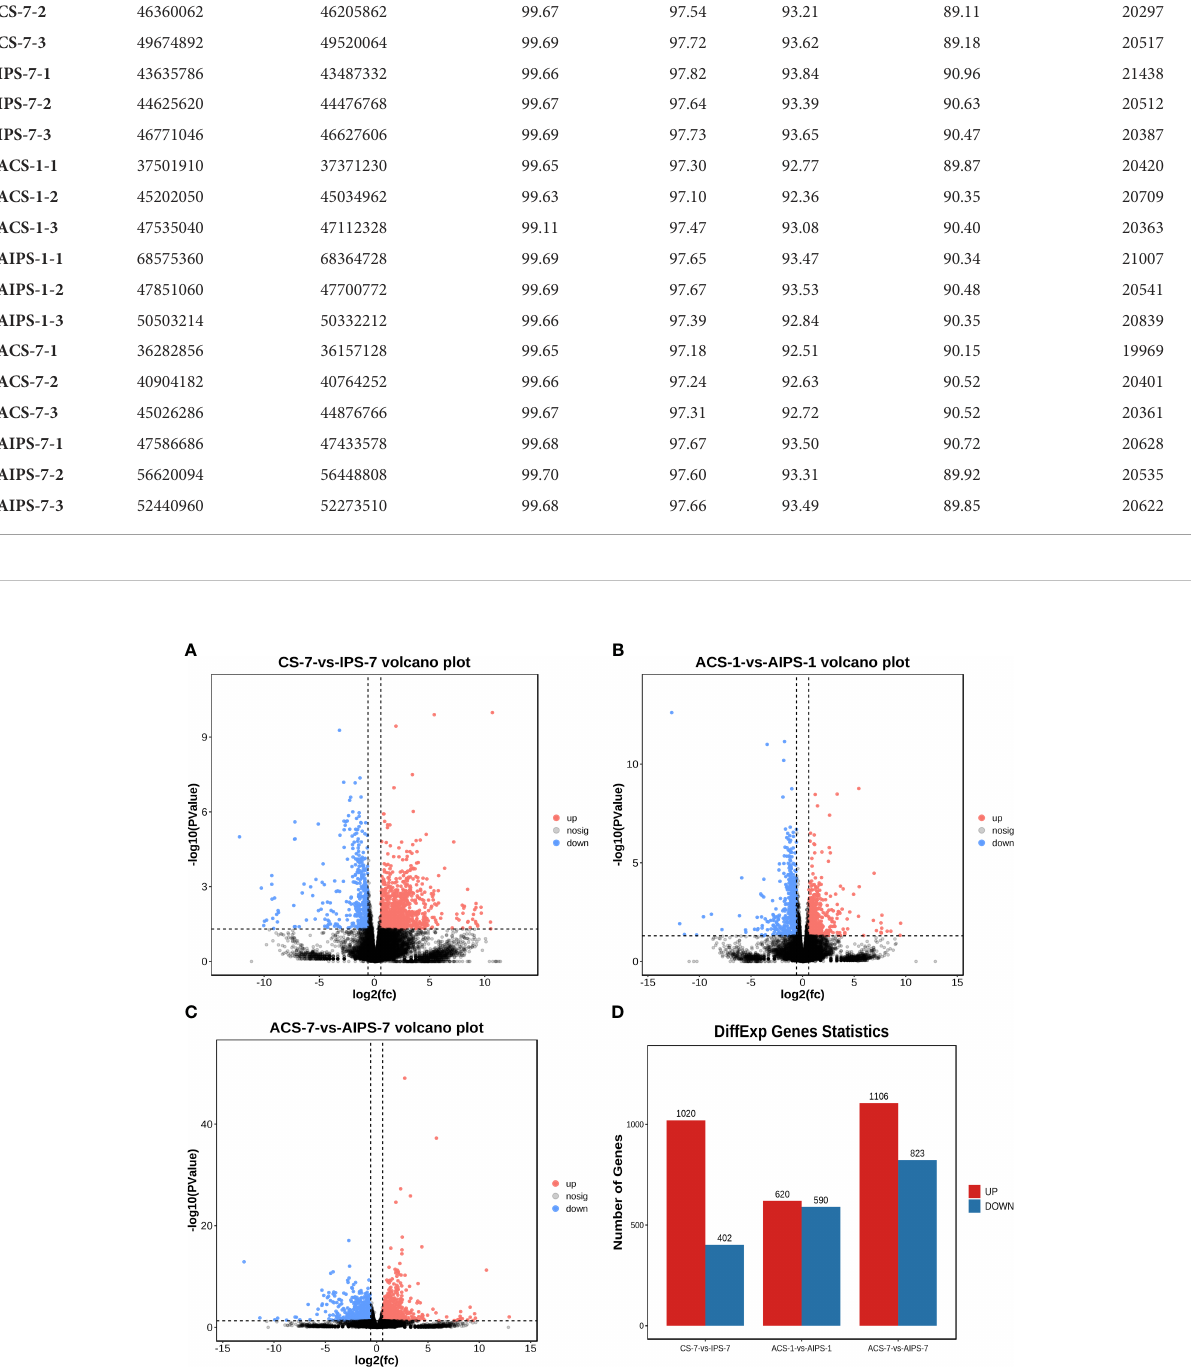
FIGURE 3 Volcano plots analysis of signi fi cantly different genes (DEGs) between samples from the PBS and inactivated vaccine groups at 7 th post immunization day (A) and 1 st (B) and 7 th (C) post challenge day. The red (expression up-regulated) and blue (expression down-regulated) points indicate differential expression of genes, and black points are no differences. Statistical plot of DEGs for the PBS and inactivated vaccine groups at three time points (D) .